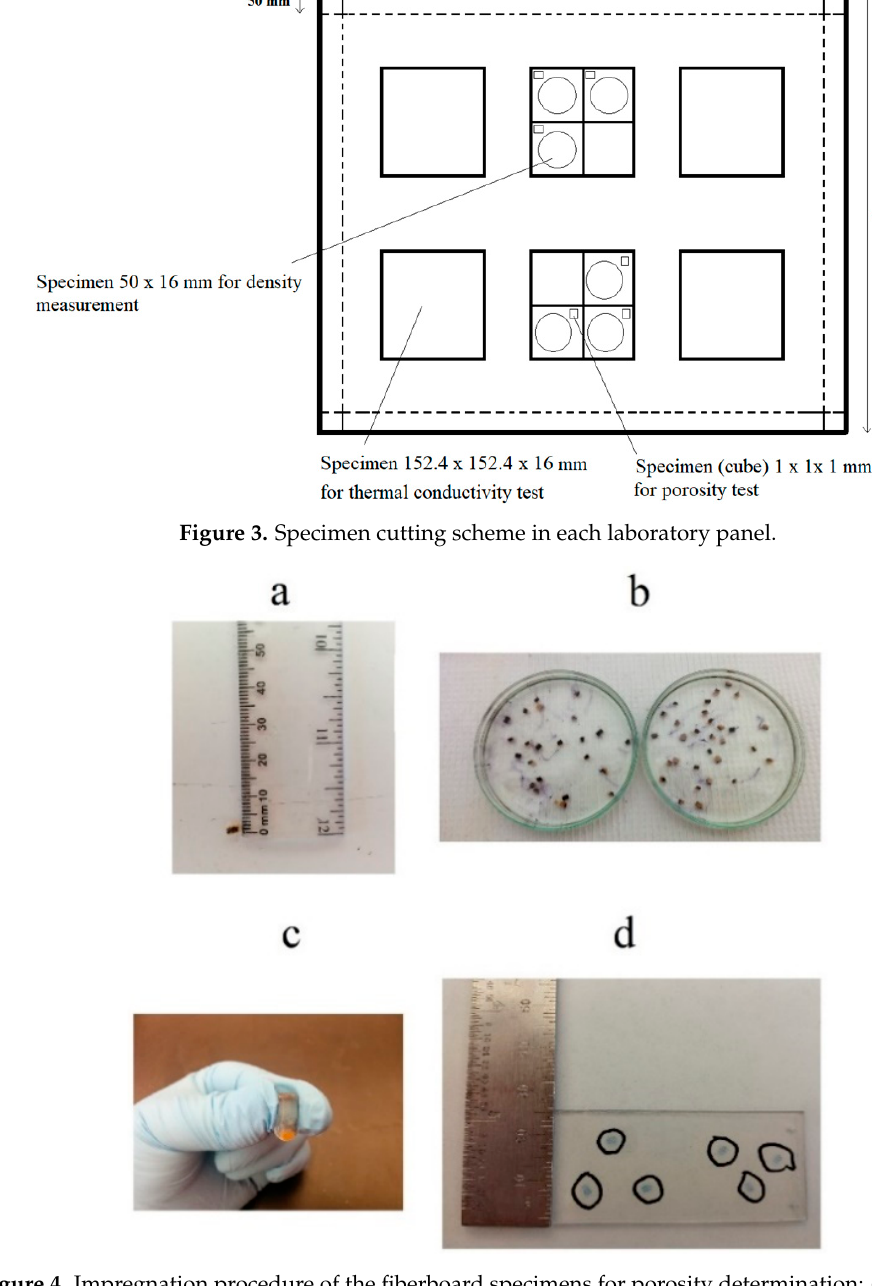
Figure 4. Impregnation procedure of the fiberboard specimens for porosity determination: ( a ) Cutting a fiberboard cube of 1 mm 3 , ( b ) Submersion of fiberboard specimen in acrylic resin, ( c ) Fiberboard specimen in polymerized resin, ( d ) Microtomed slices obtained from impregnated specimens. 2.5.